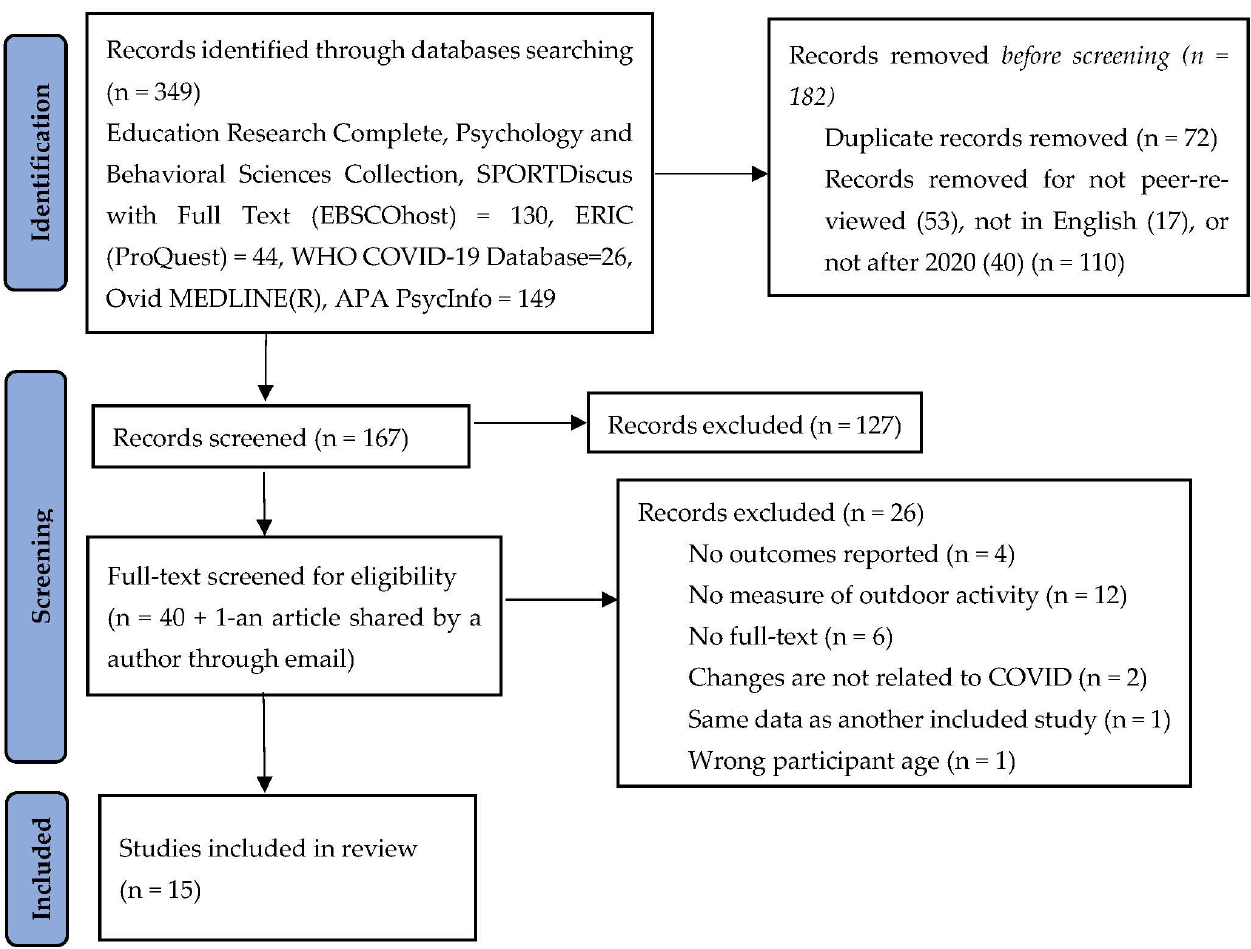
Figure 1. PRISMA flowchart of the study selection process. (PRISMA flow diagram [22]).